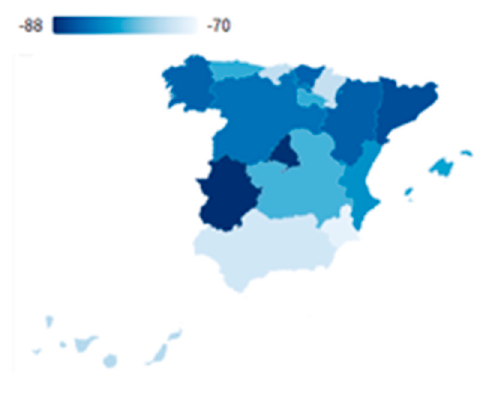
Figure 4. The inter-annual variation rates of tourist arrivals in the second quarter of 2020. Source: Own elaboration from INE data.